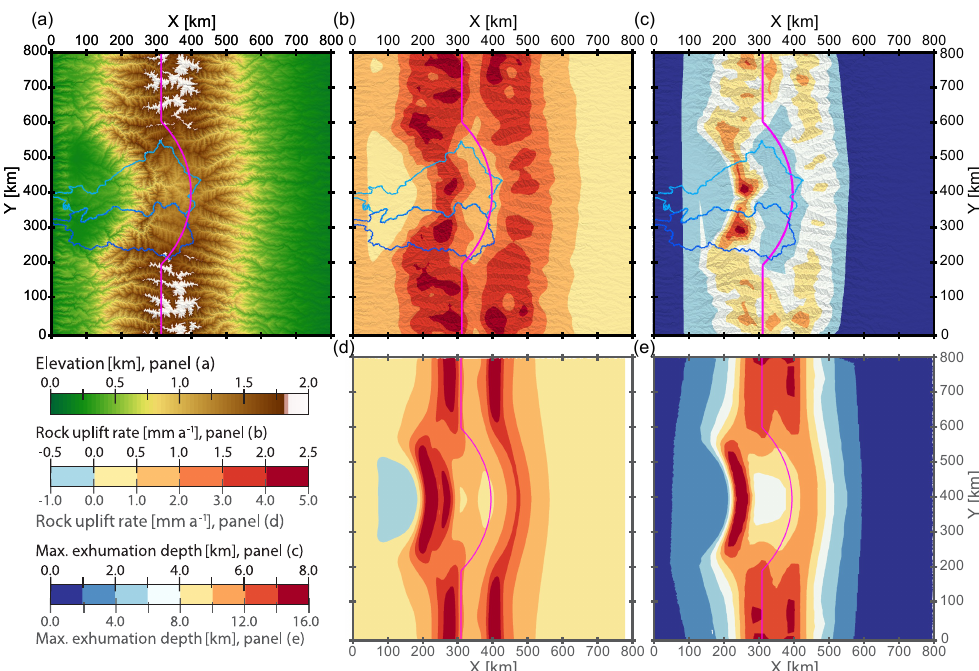
Figure 8. Comparison of rock uplift and exhumation depths with fluvial versus total erosion. (a) Surface elevations, (b) rock uplift rates, and (c) exhumation depth for model 11 (half-advance fluvial erosion) after 6.0Myr simulation time. Uplift is focused along the flanks of the orogen, with the two maxima in exhumation situated in river valleys of high erosion potential. Deepest exhumation occurs in the two uplift foci situated above the indenter ( x = 265km, y = 410km; x = 250km, y = 300km), situated within the catchments outlined in blue. Predicted thermochronometric ages are as follows: apatite (U − Th) / He: 1.3 and 1.1Ma; apatite fission track: 1.9 and 1.65Ma; and zircon (U − Th) / He 4.2 and 4.1Ma for the upper (light blue catchment) and lower (dark blue) hotspot, respectively. (d) and (e) show the flat erosion results for rock uplift rates and exhumation depth for comparison. Note the range is increased by a factor of 2 for those two plots (gray